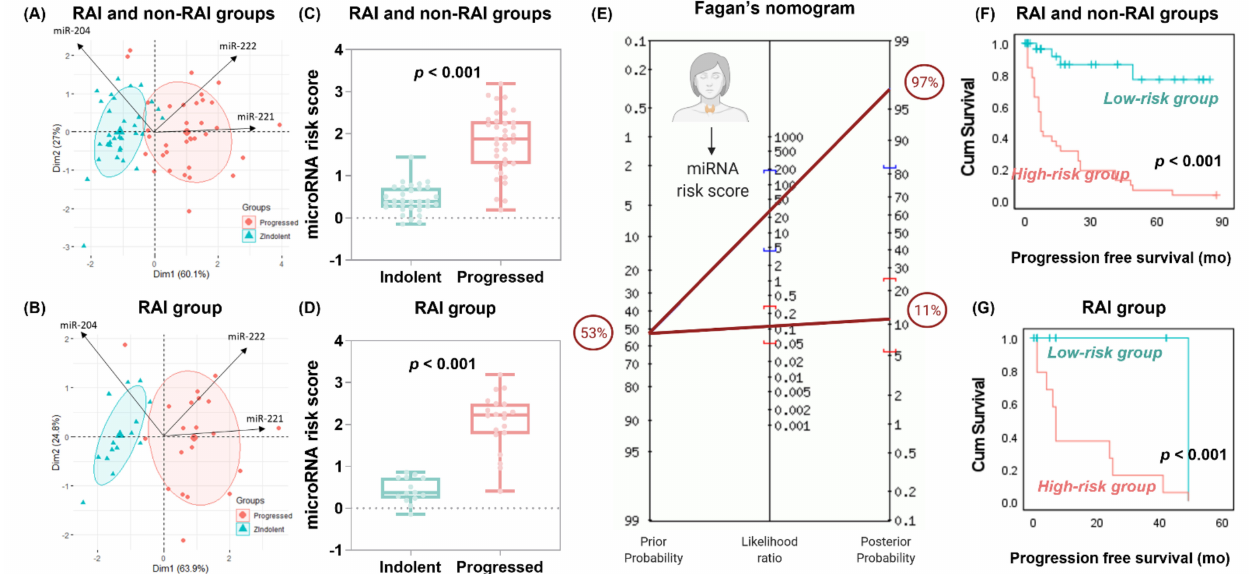
Figure 5. Predictive role of microRNA risk score. The risk score was calculated using the coefficient of the